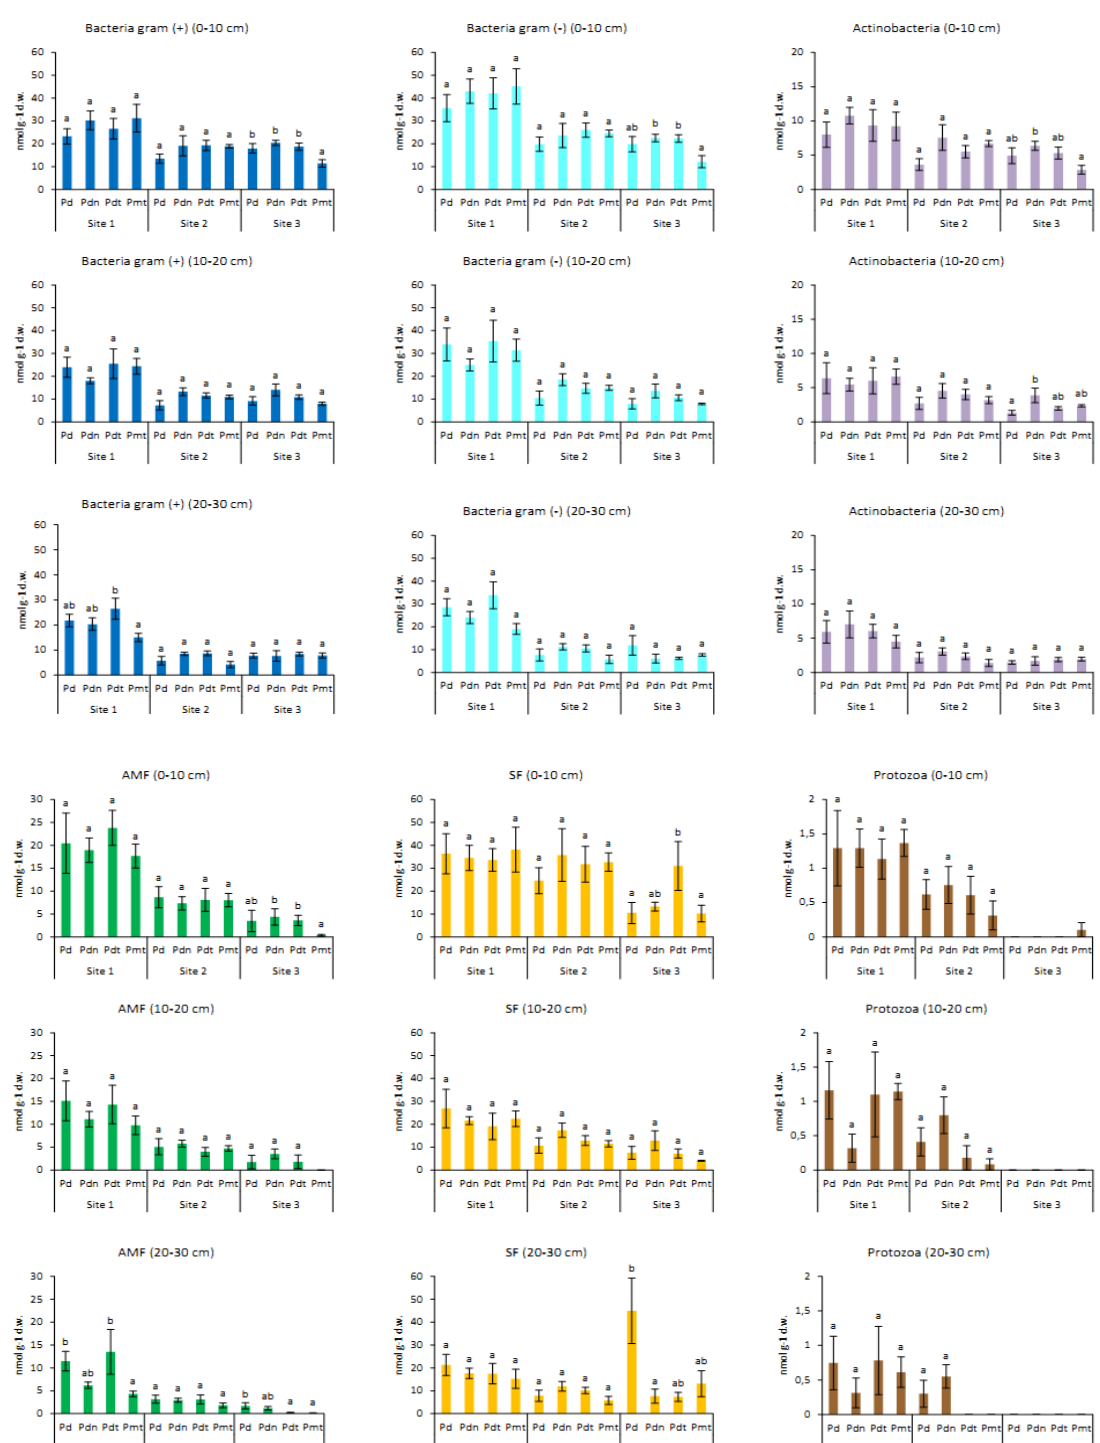
Figure 3. Biomass of microorganisms in the soil of four poplar genotypes in three sites at three rooting depths. Differences between poplar genotypes were analyzed separately for each site. Significant differences are indicated by different letters (means ± SE, p < 0.05, Tukey’s test). Pd— Populus deltoides ; Pdn— P. deltoides × P. nigra ; Pdt— P. deltoides × P. trichocarpa; Pmt— P. maximowiczii × P. trichocarpa .